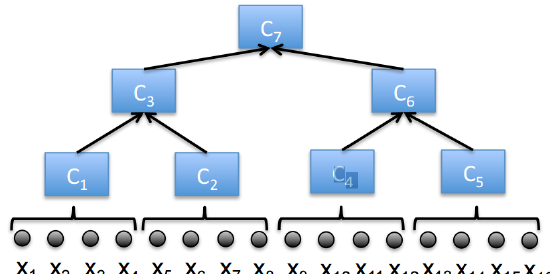
Figure 1. Coresets construction from data streams [2]. The black arrows indicate “merge-and-reduce” operations. The intermediate coresets C 1 , . . . , C 7 are numbered in the order in which they would be generated in the streaming case. In the parallel case, C 1 , C 2 , C 4 and C 5 would be constructed in